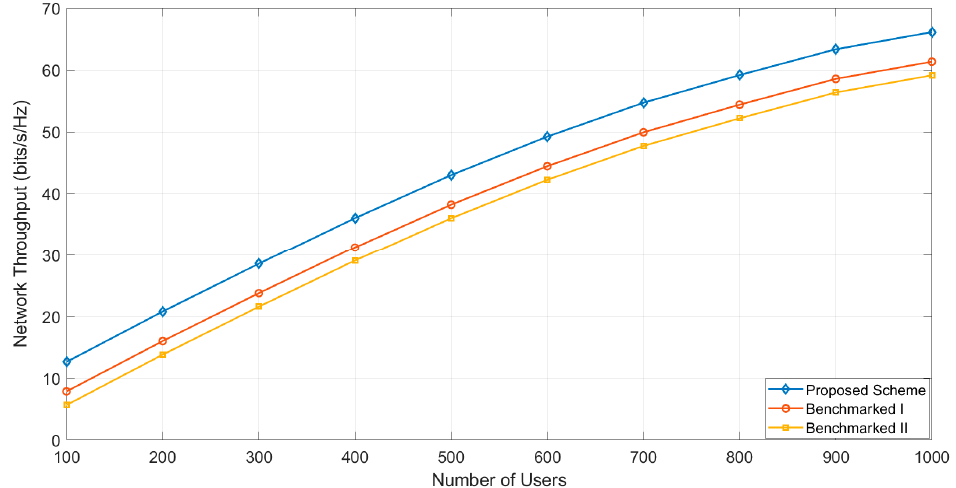
Figure 7. Network throughput V/S number of users.